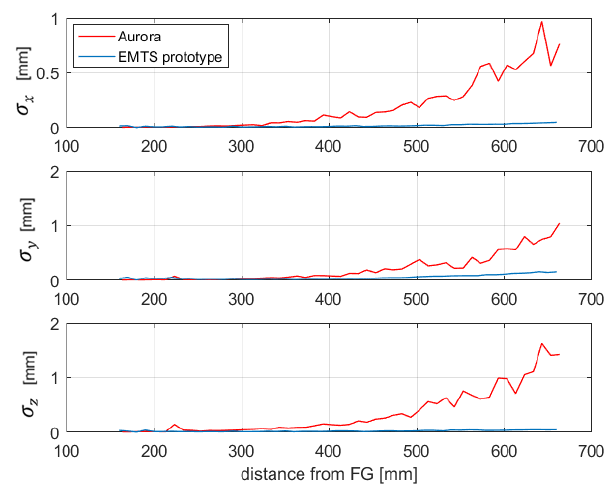
Figure 12. Comparison between the SD of the Aurora system and the EMTS prototype.